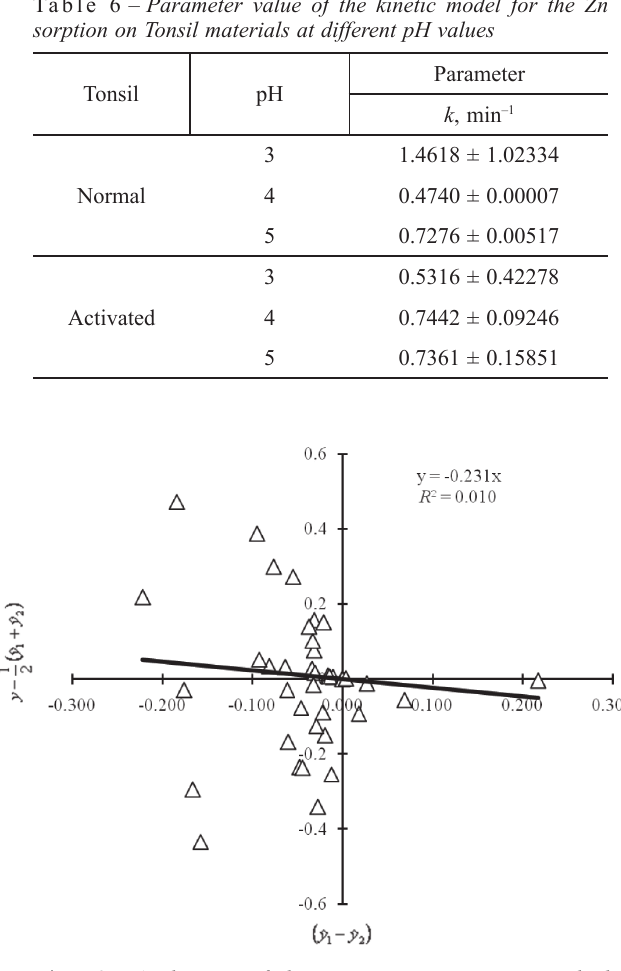
Fig. 7 – Comparison of the experimental data and calculated results for Zn sorption on normal Tonsil